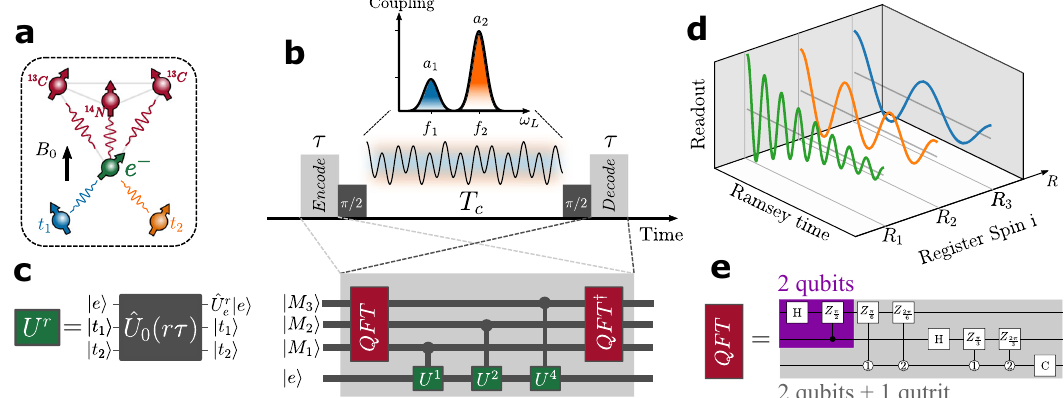
Fig. 1 Quantum Fourier transform for correlation measurements with quantum sensor – register system. a Schematic representation of the sensor consisting of a single sensor spin (green) which collects phase information of a distant target spin (blue and orange) and distributes it onto a local qubit register (red) made of one qutrit ( 14 N nuclear spin) and two qubits ( 13 C nuclear spins). b The target system spectrum, consisting of multiple frequencies f 1 , f 2 ,... with corresponding amplitudes a 1 , a 2 ,... with a schematic circuit for sensing of multiple target spins with implementation of QFT and QFT † . c The phase acquisition unitary gate for sensing of target nuclear spins t 1 and t 2 . d The readout result of the register qubits after performing measurements with the QFT algorithm. Each memory stores Ramsey oscillation of individual target nuclear spins. e QFT † quantum circuit for our hybrid quantum